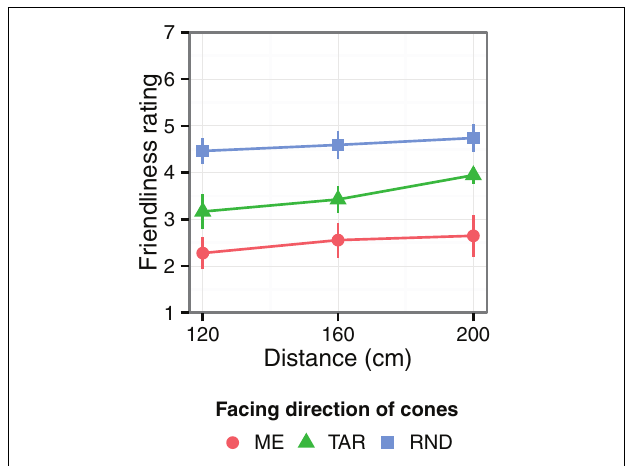
FIGURE 3 | The results of Experiment 2. Larger values indicate that the cones were evaluated as being friendlier and less hostile. The error bars indicate the standard error of the